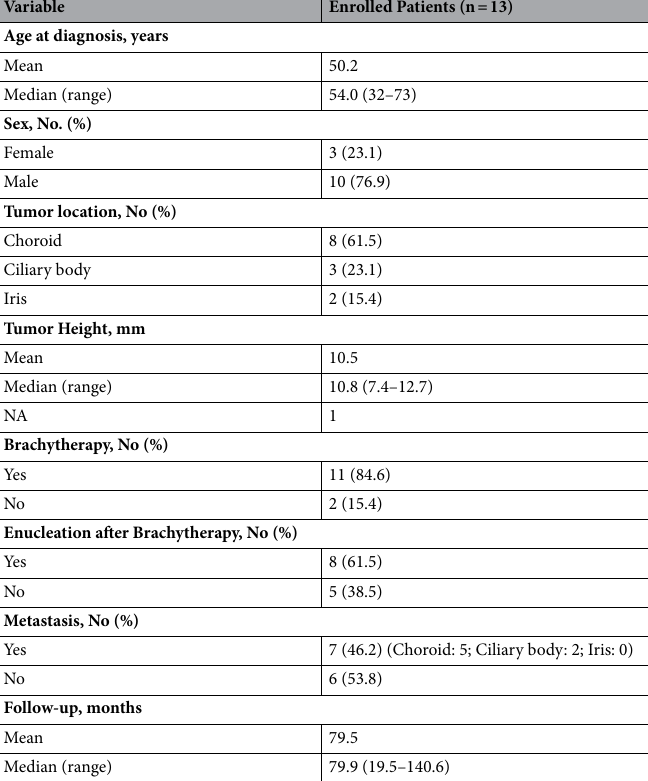
Table 1. Summary of demographical and clinical data in enrolled uveal melanoma